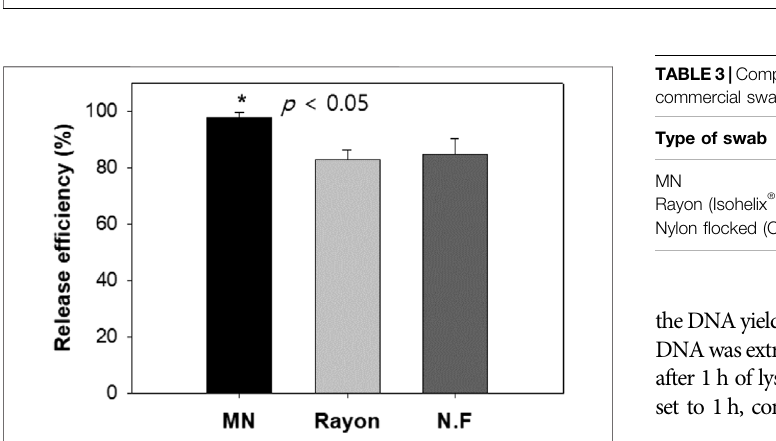
FIGURE 11 | SEM images for comparison of morphology of MN swab and commercial swabs. From left: (A) MN swab, (B) Rayon swab (Isohelix ® ), (C) Nylon fl ocked swab (Copan eSwab ® ) (scale bars, 200 μ m).